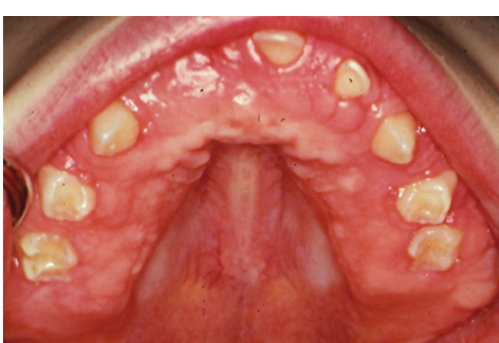
Figure 3: 10-day after surgery.